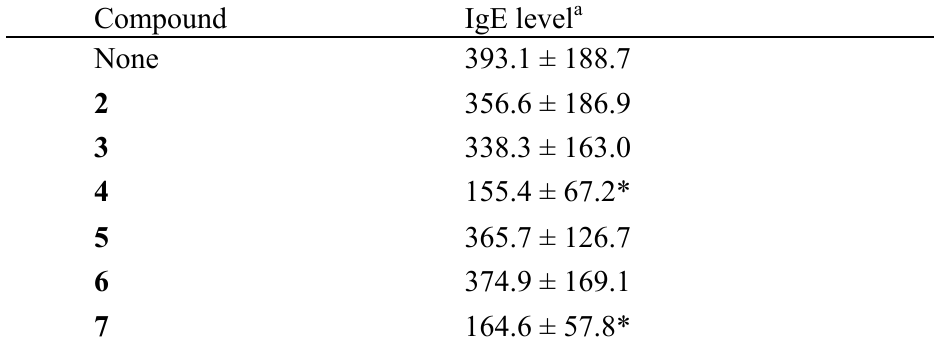
Table 1. Suppressive action of hesperetin α -glycosides 2 - 7 on IgE antibody formation.